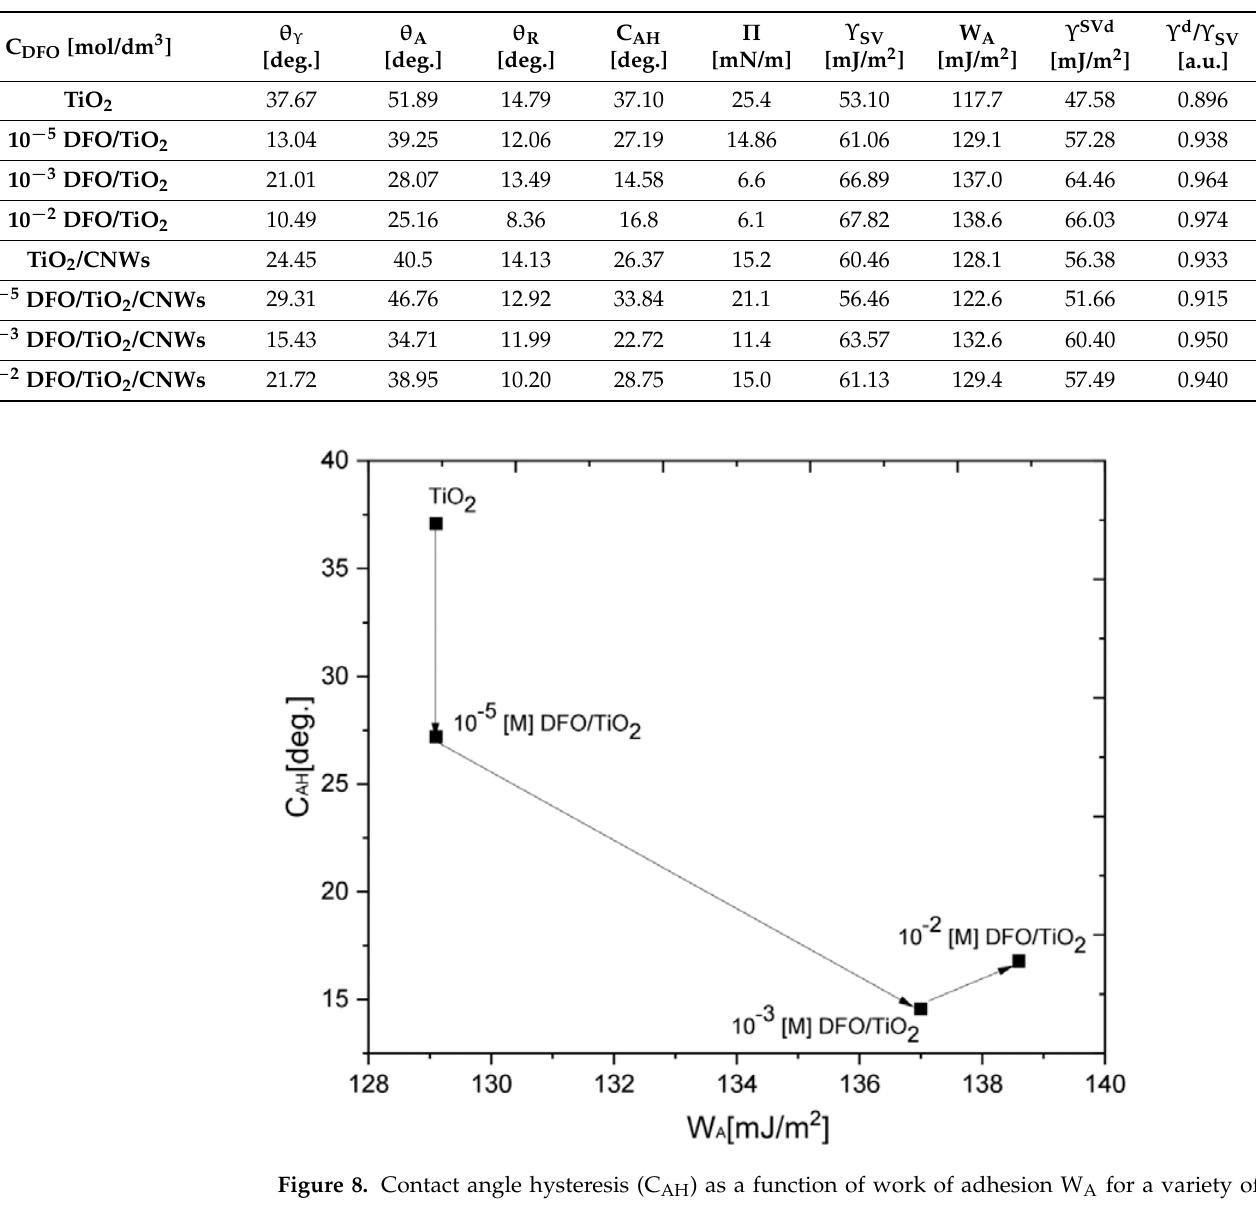
Table 2. Wettability parameters (mean values) of studied solid substrata in contact with distilled water,